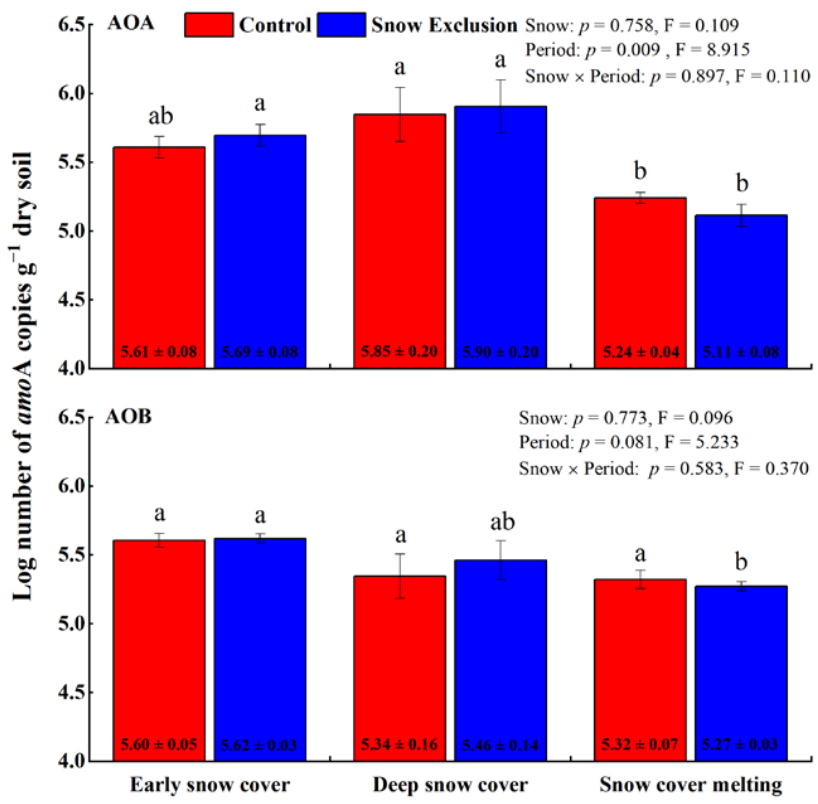
Figure 1. The abundances of soil AOA and AOB amoA gene copy numbers (log 10 transformed) in winter control and snow exclusion plots. Error bars represent the standard deviation ( n = 3). Data shown are mean ± s.e. Different lowercase letters indicate significant differences between sampling periods under the same snow regime. p -Values for snow treatment (Snow), sampling period (Period), and their interactions from repeated measures ANOVA are inserted in the figure.